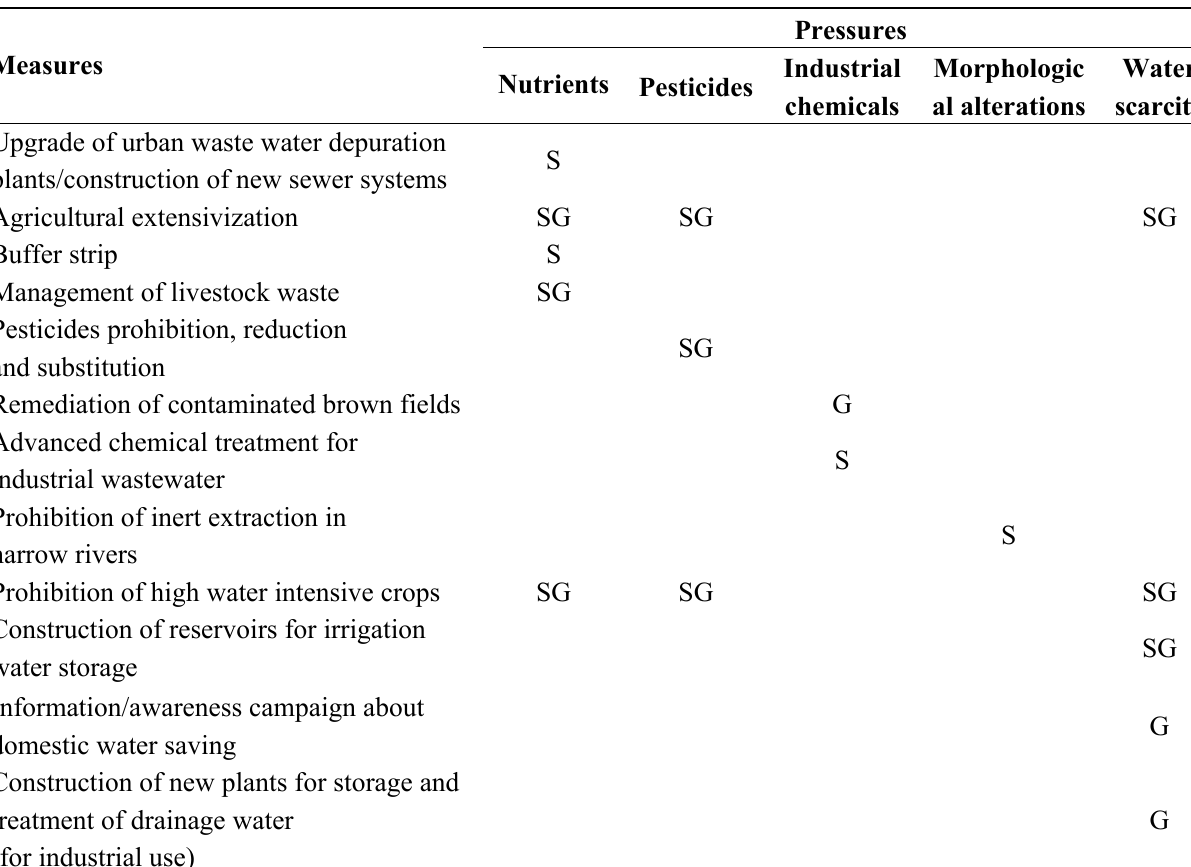
Table 1. Interactions between measures and pressures (S = surface waters; G =